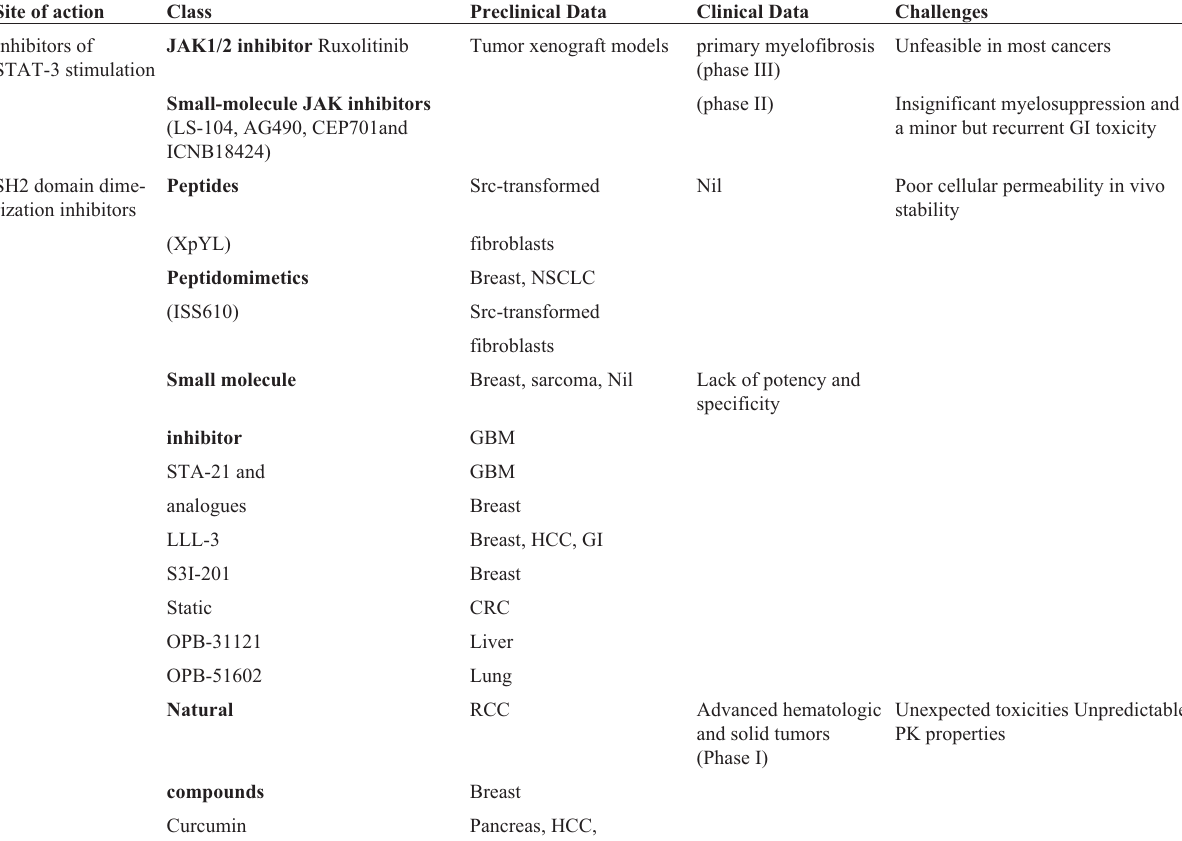
Table 2 - Targets and Inhibitors of the STAT-3 signaling